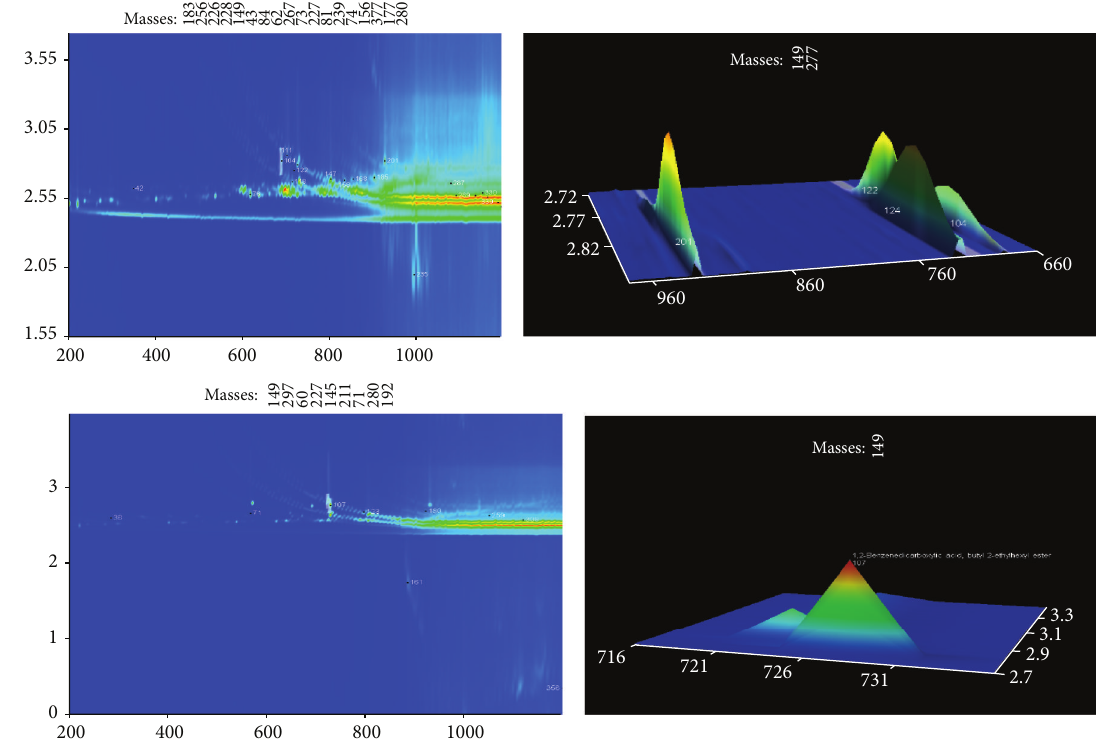
Figure 2: 2D chromatograms showing the compounds extracted in raw water using C-18 SPE and determined by using deconvolution ChromaTOF software in the GC × GC-TOFMS technique. Aromatic acids are shown as zoomed chromatograms to the right and indicated by arrows. The respective names, retention times, and GC-library similarities of selected compounds are tabulated (Table